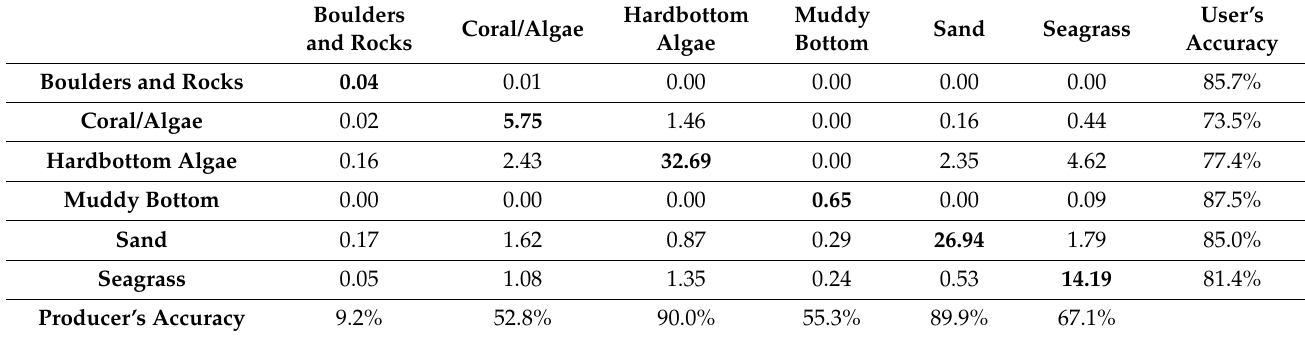
Table 10. Accuracy assessment results of the six-class major benthic habitat types after combining sparse and dense seagrass as well as sparse and dense hardbottom algae. The numbers in the diagonal cells (depicted in bold) represent the proportion of total area correctly classified for each benthic class. The reported overall accuracy for this analysis is 80% (not shown in the table). All numbers reported in each table represent the proportion of total